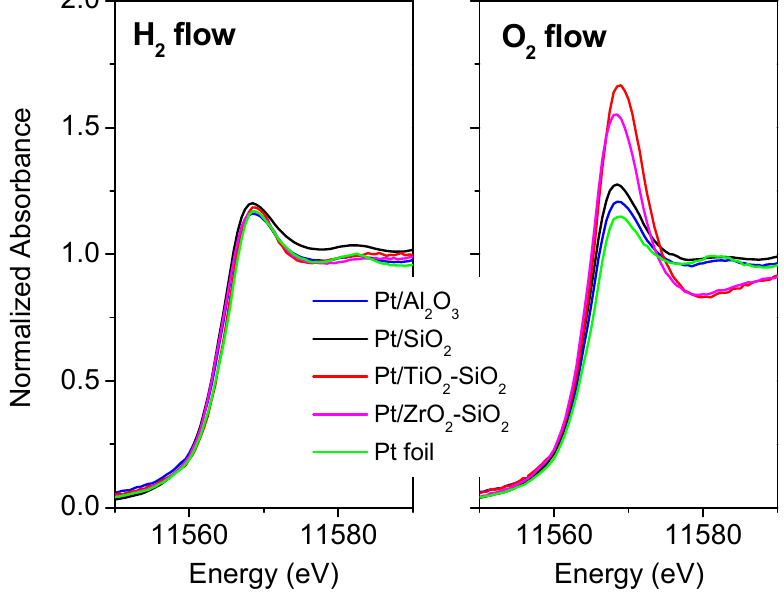
-edge XANES spectra obtained at 400 °C for Pt/Al Figure 3. Pt L III Pt/TiO -SiO , Pt/ZrO -SiO , and Pt foil in H 2 2 2 2